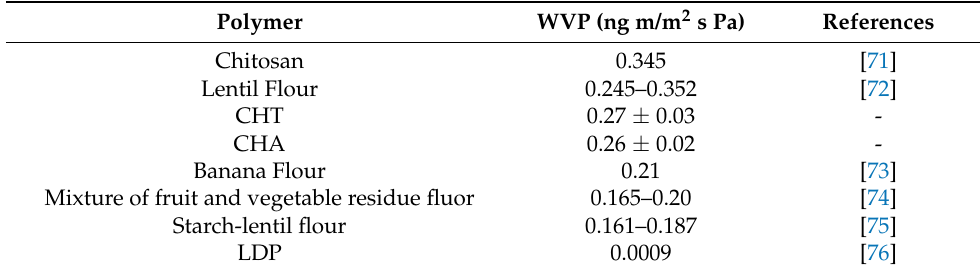
Figure 8. Water vapor permeability of CHT and CHA films. Table 6. Water vapor permeability of some novel biopolymers and low-density polyethylene [28].